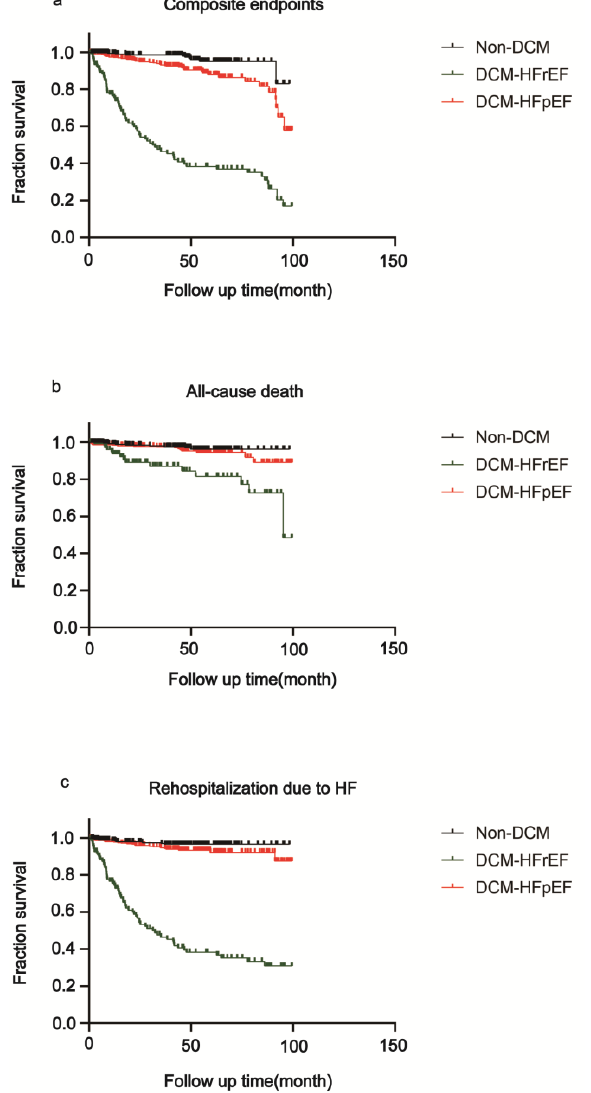
Figure 4. Kaplan–Meier survival analysis after a median follow-up of 45.4 months. Kaplan–Meier estimates for a composite of all-cause death and rehospitalization due to HF among DCM-HFpEF, non-DCM and DCM-HFrEF patients. (a) HFrEF showed the lowest event-free rate for composite endpoints, followed by DCM-HFpEF. (b) HFrEF showed the lowest event-free rate for all-cause death, followed by DCM-HFpEF. (c) HFrEF showed the lowest event-free rate for rehospitalization due to HF, followed by DCM-HFpEF. DCM: diabetic cardiomyopathy; HFrEF: heart failure with reduced ejection fraction; HFpEF: heart failure with preserved ejection fraction.